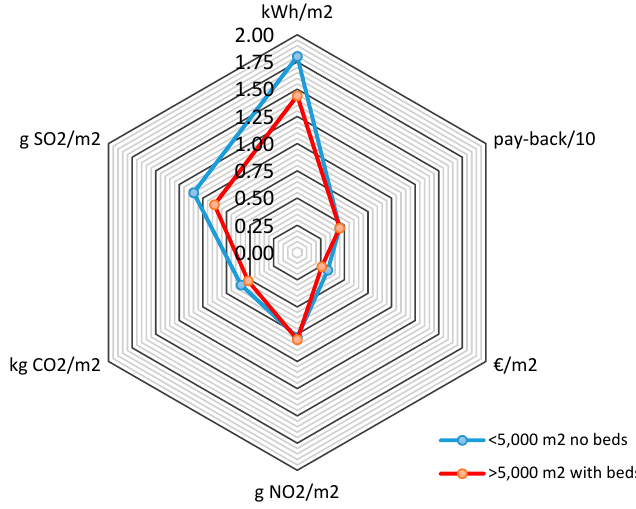
Figure 2. Potential of energy saving derived from improvement of air conditioning and heating (HVAC) systems.